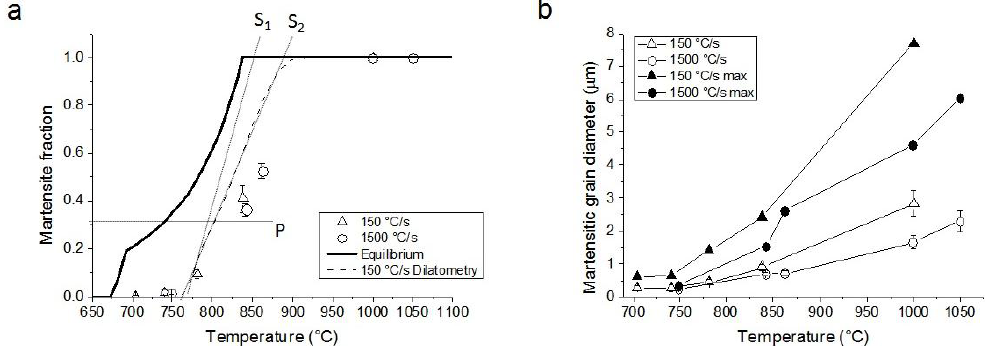
Figure 2. ( a ) Martensite fraction versus annealing temperature for samples heated at 150 °C/s and 1500 °C/s and ( b ) average martensitic grain size (outlined) and maximum martensitic grain size (filled) versus annealing temperature. The solid black line in ( a ) represents the equilibrium fraction of austenite calculated with ThermoCalc, whereas the black dashed line represents the austenite fraction measured by dilatometry. S 1 and S 2 respectively represent the slopes at the beginning and later stages of austenite formation. The line labeled P represents the initial volume fraction of pearlite. In both plots, triangles and circles represent samples annealed with 150 °C/s and 1500 °C/s, respectively.